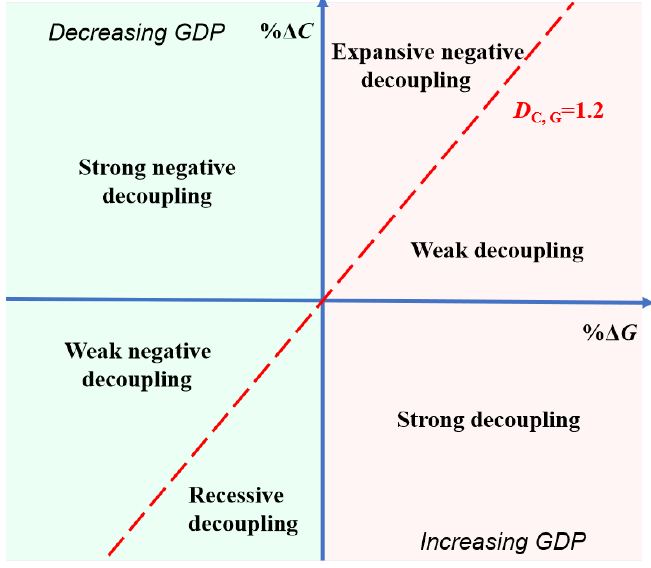
Figure 1. Classification of decoupling states.